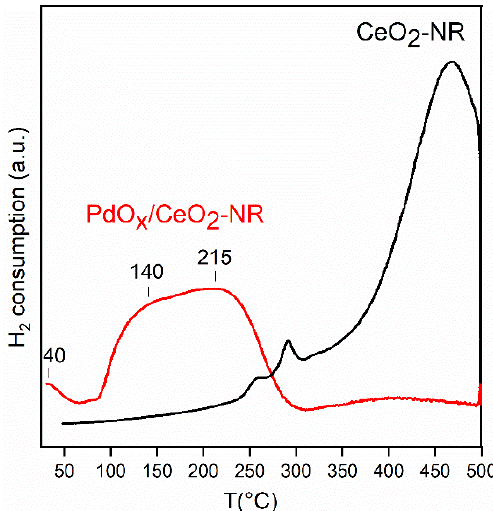
Figure 5. Temperature programmed reduction (H 2 -TPR) profiles of the CeO 2 -NR and PdO x /CeO 2 - NR samples. Table 3. Redox properties by H 2 -TPR analysis: hydrogen consumption and reduction degree of Pd and